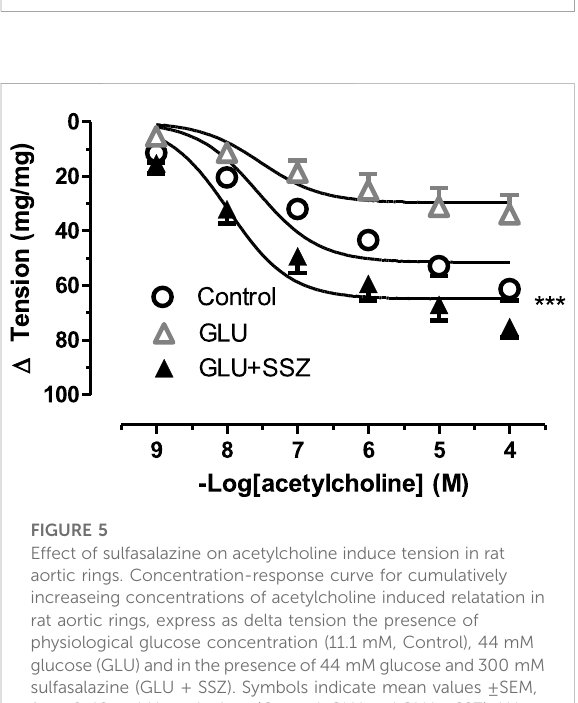
FIGURE 4 Effect of sulfasalazine on noradrenaline induce tension in rat aortic rings. Concentration-response curve for cumulatively increasing concentrations of noradrenaline in the presence of physiological glucose concentration (11.1 mM, Control), 44 mM glucose (GLU), 44 mM glucose and 300 mM sulfasalazine (GLU + SSZ). Symbols indicate mean values ±SEM, from 8, 7 and 8 aortic rings (Control, GLU and GLU + SSZ). *** p < 0.0001 for smaller E max in GLU + SSZ vs. GLU (F-test).